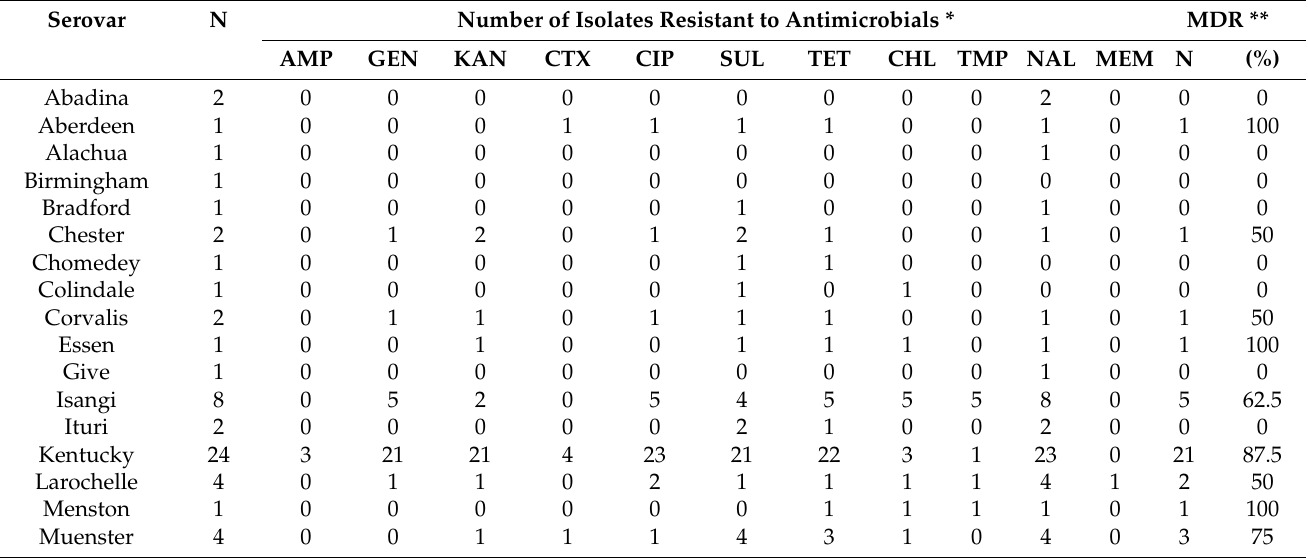
Table 1. Phenotypic antimicrobial resistance in Salmonella serovars from commercial poultry farms in Nigeria. Serovar N Number of Isolates Resistant to Antimicrobials * Abadina